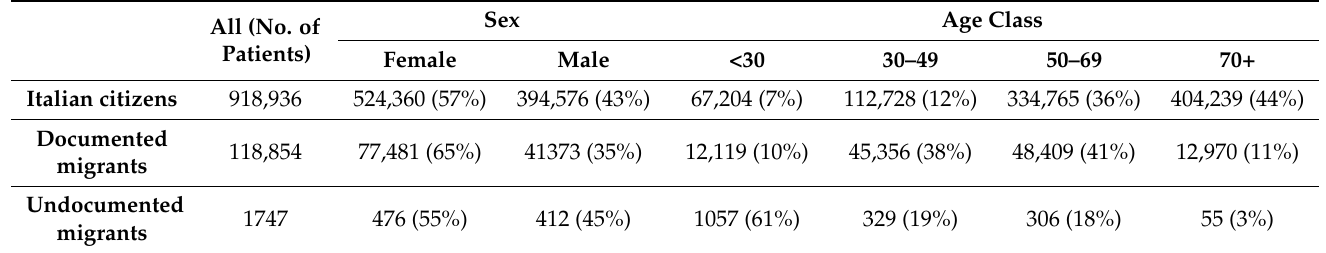
Table 1. Number of patients receiving healthcare services provided in 2018-2019, grouped by sex and age